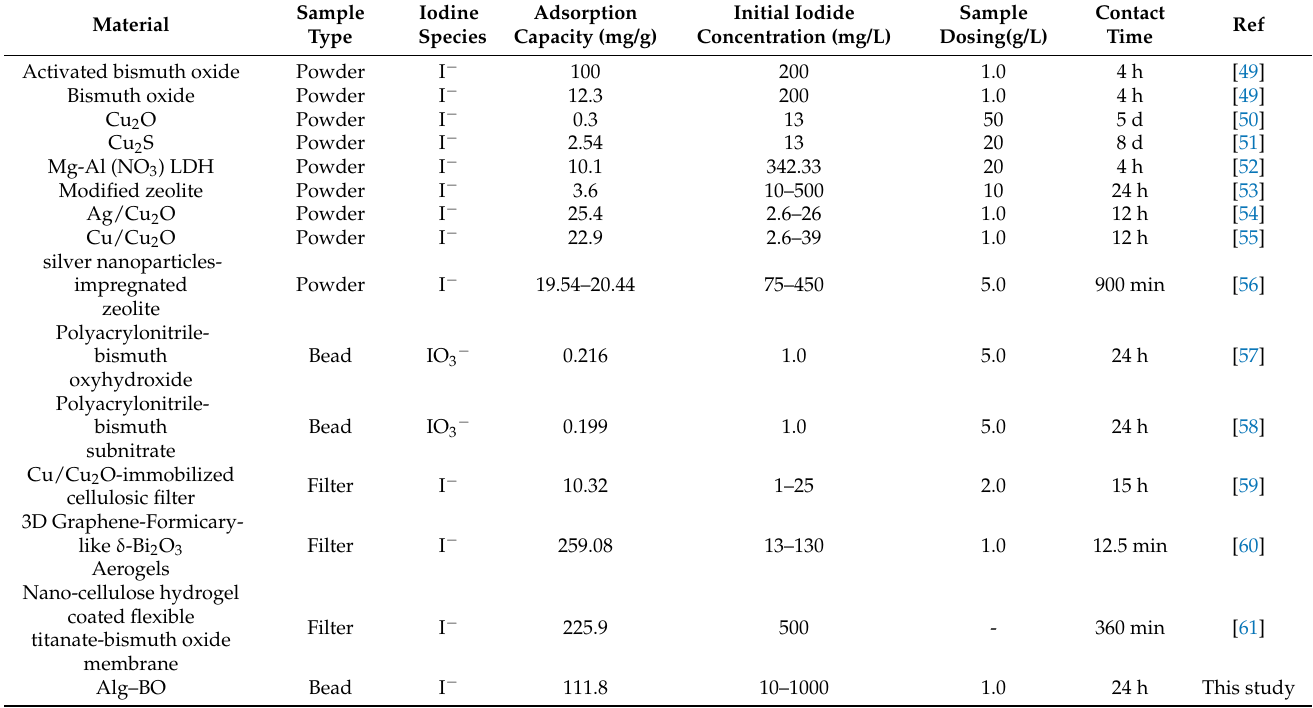
Table 2. Summarized iodine species adsorption capacity of various